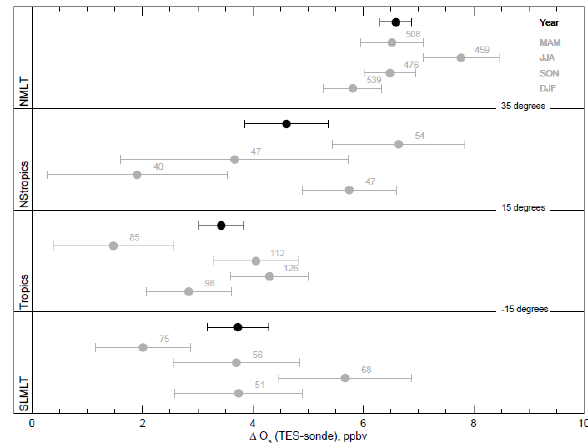
2 Figure 5. Mean 2005-2010 TES bias in ozone at 464 hPa per latitude zone (black symbols)3 Fig. 5. Mean 2005–2010 TES bias in O 3 at 464hPa per latitude zone and their standard errors (including data pairs numbers and standard errors). Grey symbols4 (black symbols) and their standard errors (including data pairs num- indicate the seasonal mean biases and their standard errors. NMLT: Northern mid-latitudes;5 bers and standard errors). Grey symbols indicate the seasonal mean NStropics: Northern sub-tropics; SLMT: Southern lower and mid-latitudes.6 biases and their standard errors. NMLT: northern mid-latitudes; NStropics: northern sub-tropics; SLMLT: southern lower and mid-